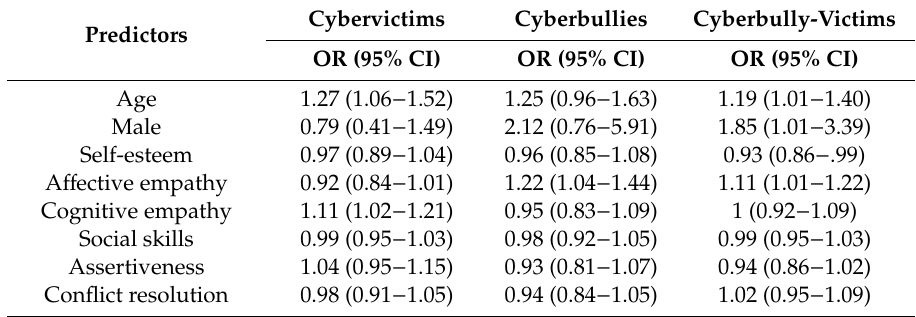
Table 4. Multinomial regression with age, gender, self-esteem, empathy, and social skills as predictors of di ff erent cyberbullying